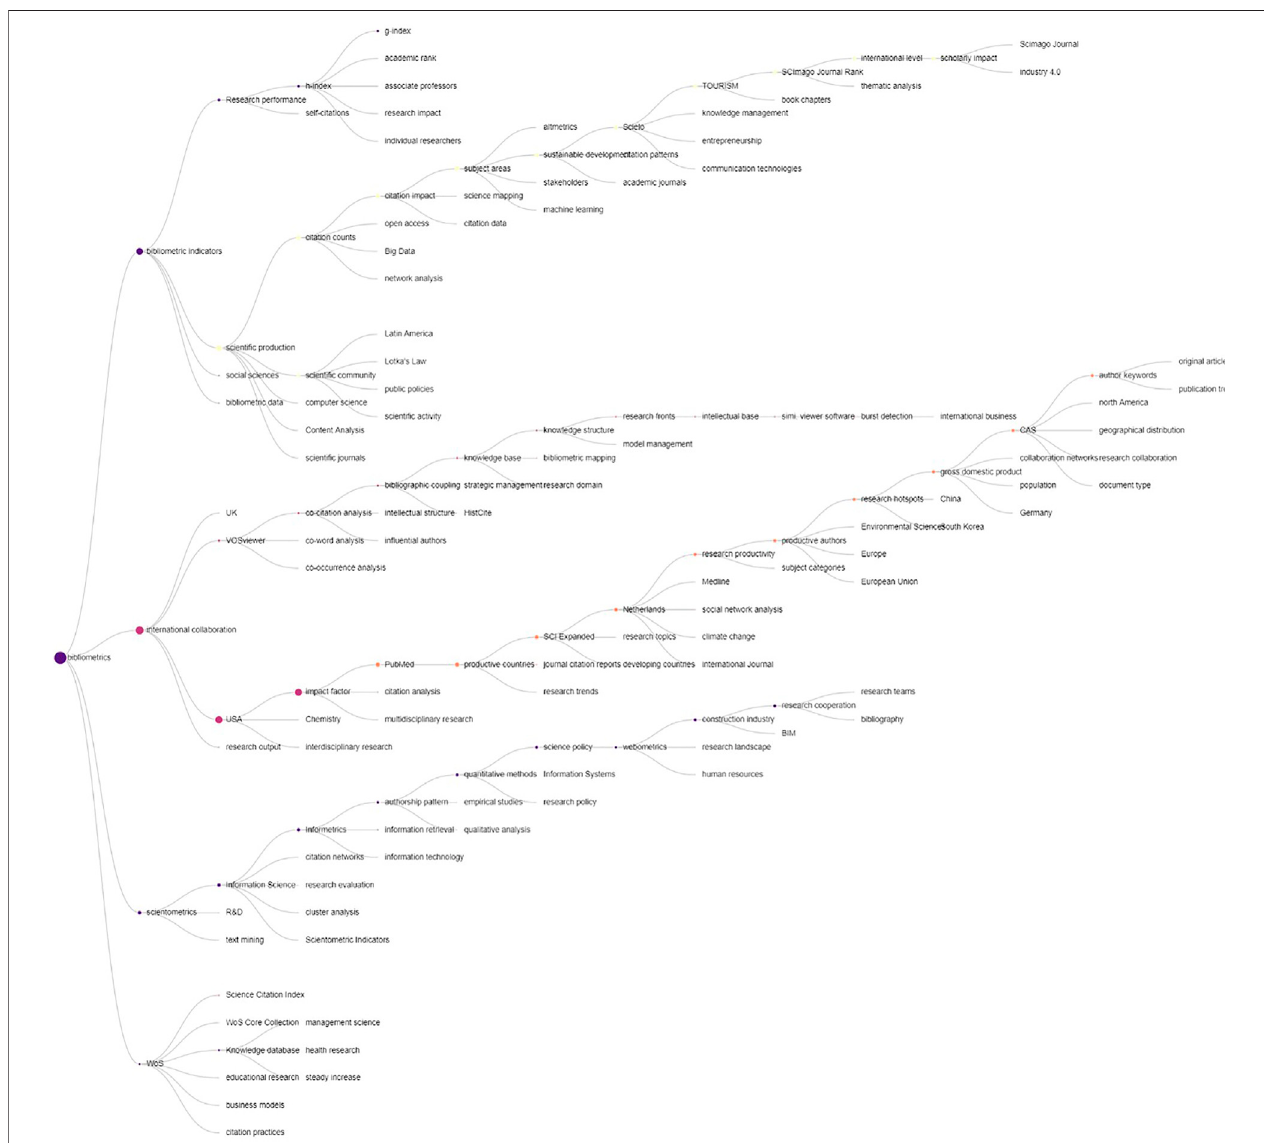
FIGURE 7 | Hierarchical topic tree of bibliometric